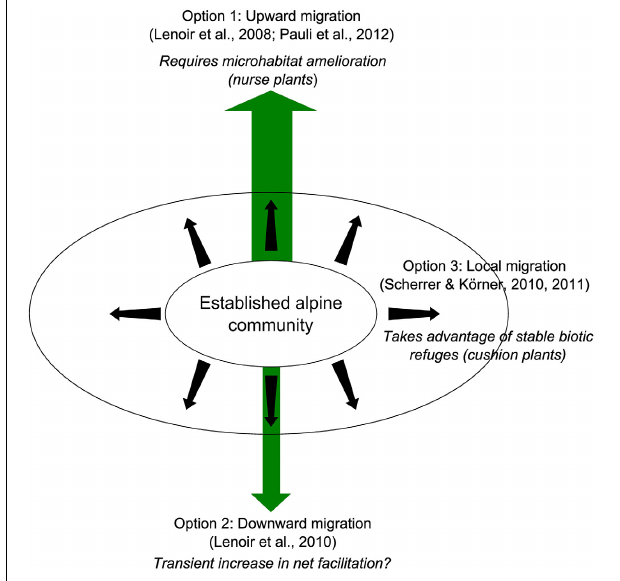
FIGURE 7 | Three migration scenarios for alpine plant communities under the effects of warming (upward, downward, local) involving three potential facilitative interactions among